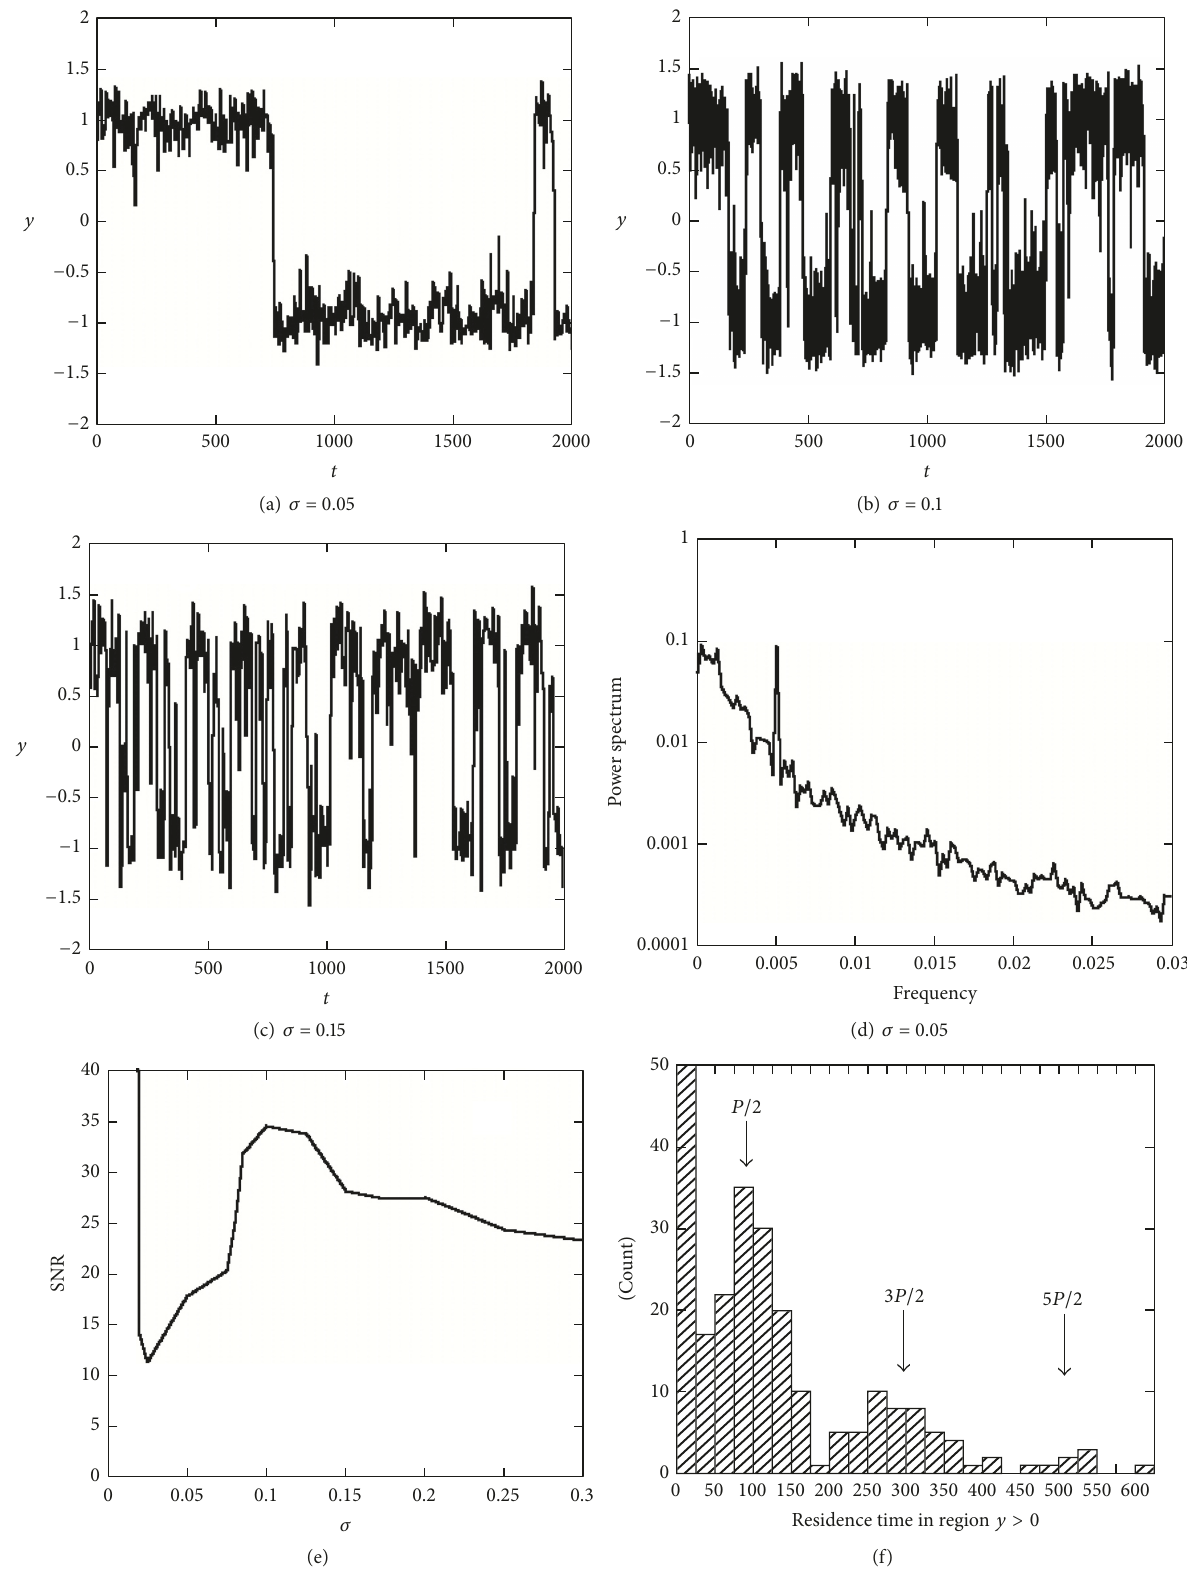
Figure 8: (a–c) Time series illustrating the evolution of a variable 𝑦 in a double well potential, subjected to a weak periodic signal and to white noise fluctuations for a noise intensity of (a) 𝜎 = 0.05, (b) 𝜎 = 0.1, and (c) 𝜎 = 0.15. (d) Power spectrum of (a). (e) Signal-to-noise ratio as a function of the noise intensity showing a maximum at 𝜎 ∼ 0.11 . (f) Residence time distribution for the region 𝑦 > 0 for 𝜎 =